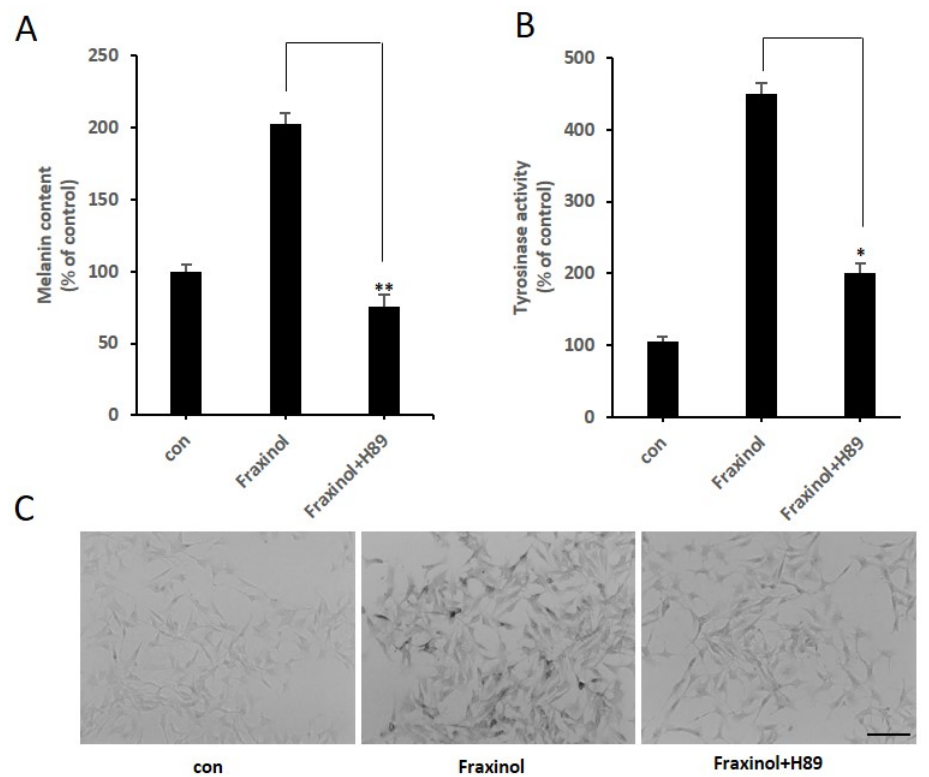
Figure 6. Effects of a PKA inhibitor on fraxinol-induced tyrosinase activation and melanin contents in B16F10 cells. B16F10 cells pretreated with or without H89 (10 µ M) for 1 h were stimulated with fraxinol (100 µ M) for 48 h. ( A ) Melanin content is expressed as percentages compared to the respective value obtained for the control cells (non-treated cells). ( B ) Tyrosinase activity is presented as a percentage compared to the respective value obtained for the control cells (no treatment). ( C ) Intracellular tyrosinase activity was observed using a light microscope after DOPA staining (scale bar, 100 µ m). The data are presented as the means ± SD; n = 3. * p < 0.01, ** p < 0.001 compared to the fraxinol ‐ treated group.